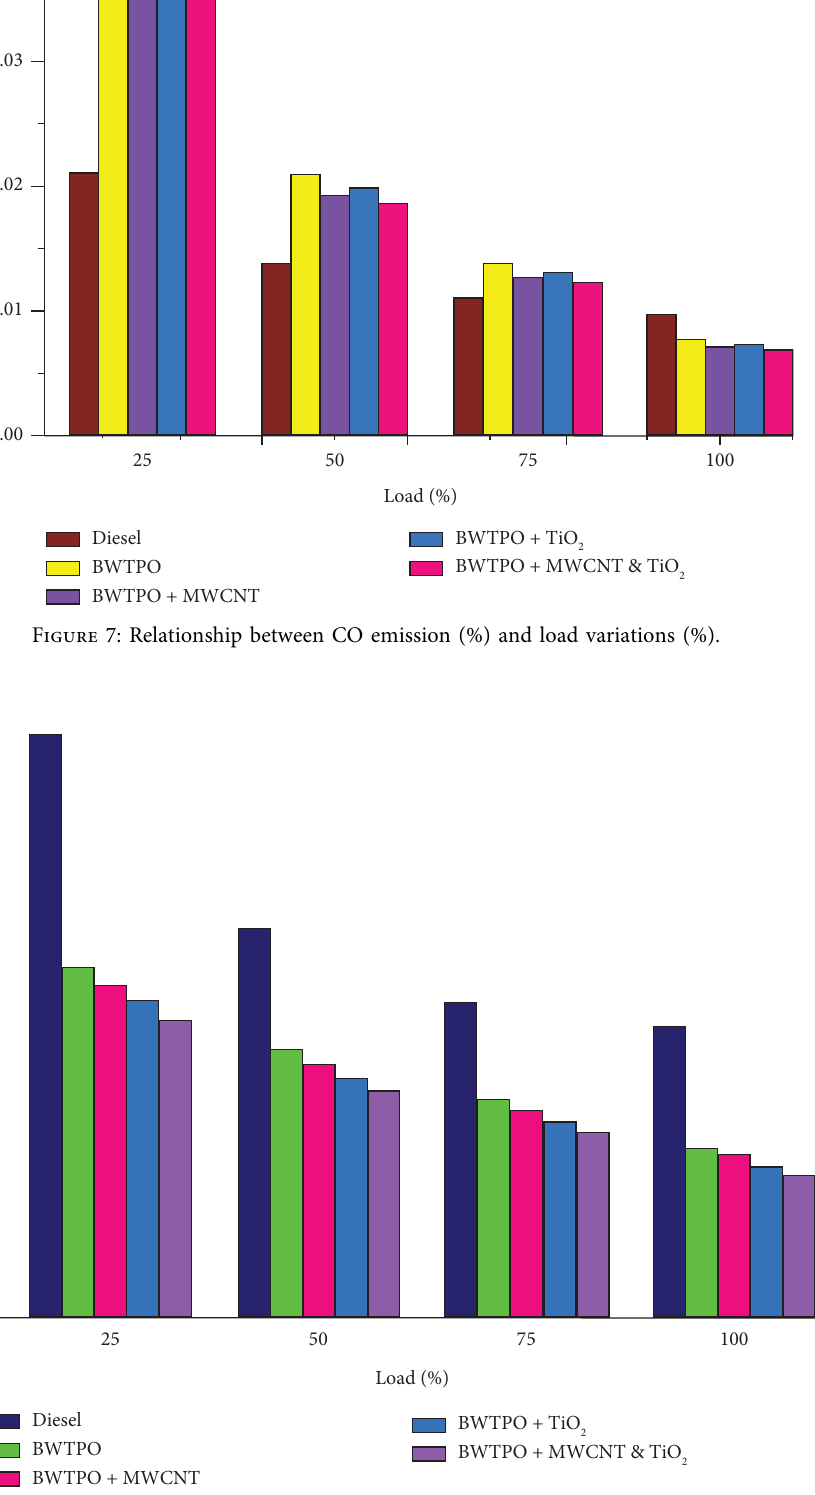
Figure 8: Relationship between HC emissions (ppm) and load variations